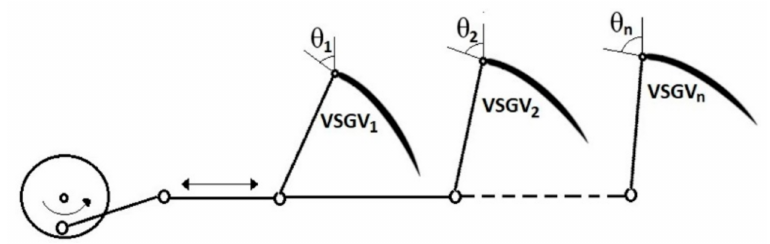
Figure 28. The variable stator guide vane (VSGV) mechanism in the axial